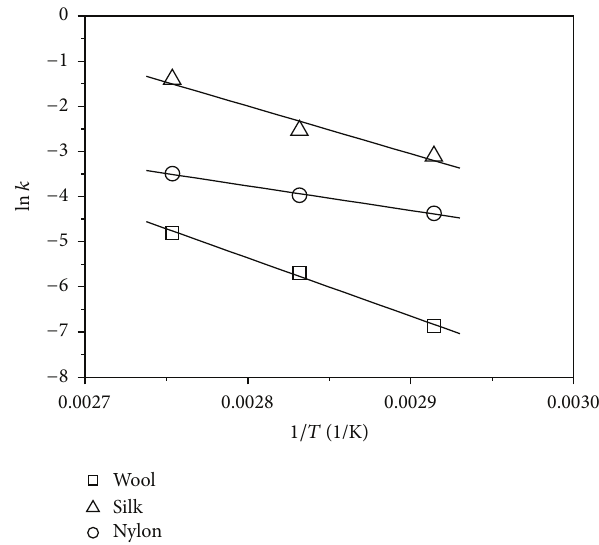
Figure 3: Plots of ln 𝑘 versus 1/𝑇 for the adsorption of lac dyes on wool, silk, and